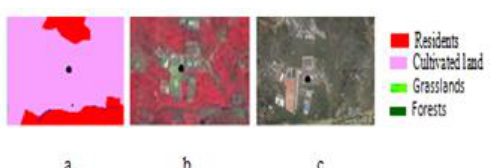
Figure 1 Cultivated land is extracted residents (black point)